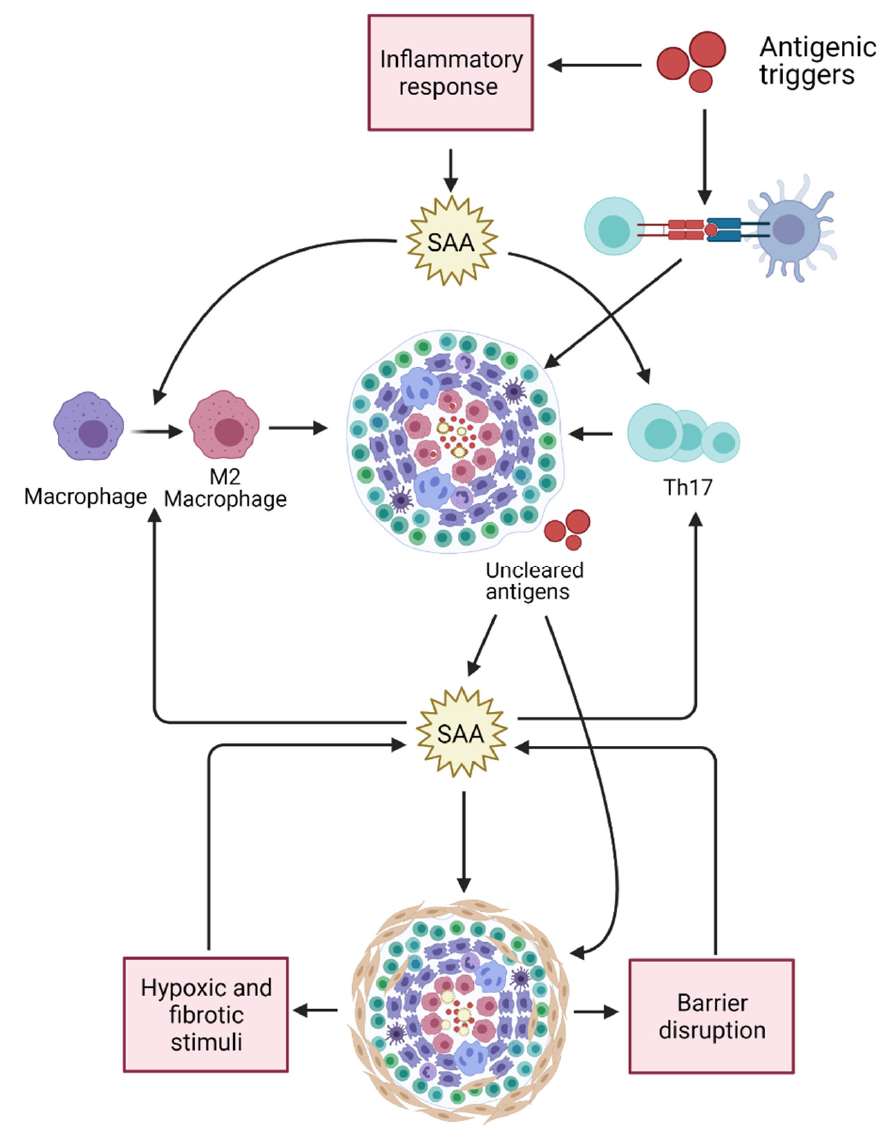
Figure 3. Multiple effects of SAA may relate to its contribution in sarcoidosis pathogenesis. SAA levels are upregulated in response to (bacterial) antigens stimulating the innate immune system. SAA contributes in Th17-cell proliferation, Th17 cytokine production, and in M2 polarization of macrophages. Both Th17 cells as well as M2 macrophages are thought to be involved in sarcoido- sis pathogenesis and granuloma formation. Accumulation of SAA might result in misfolding or aggregation of SAA and formation of complexes with other matrix proteins, leading to granuloma formation and entrapment of antigens. SAA serum levels and tissue expression may result in chronic inflammation and fibrosis. SAA levels may be further increase in response to fibrotic and hypoxic stimuli. Fibrosis is often accompanied by low-grade inflammation and tissue-barrier disruption, which may also lead to an upregulation of SAA levels since SAA contributes to (bacterial) antigen clearance. Created with BioRender.com (accessed on 3 March